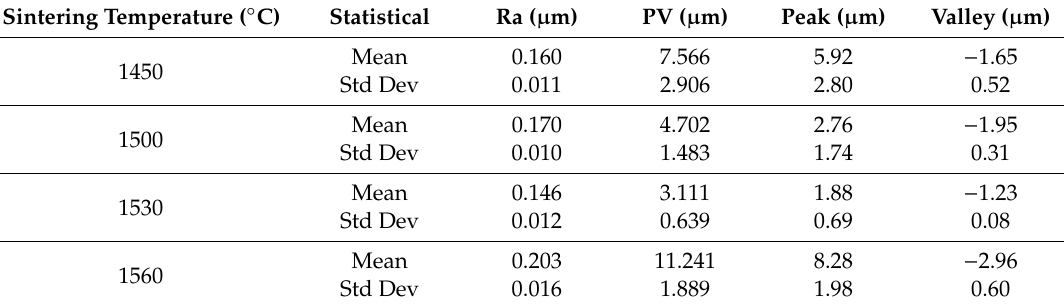
Table 2. Roughness of 3Y-SBE group after sintered at di ff erent temperatures ( ◦ C). Sintering Temperature ( ◦